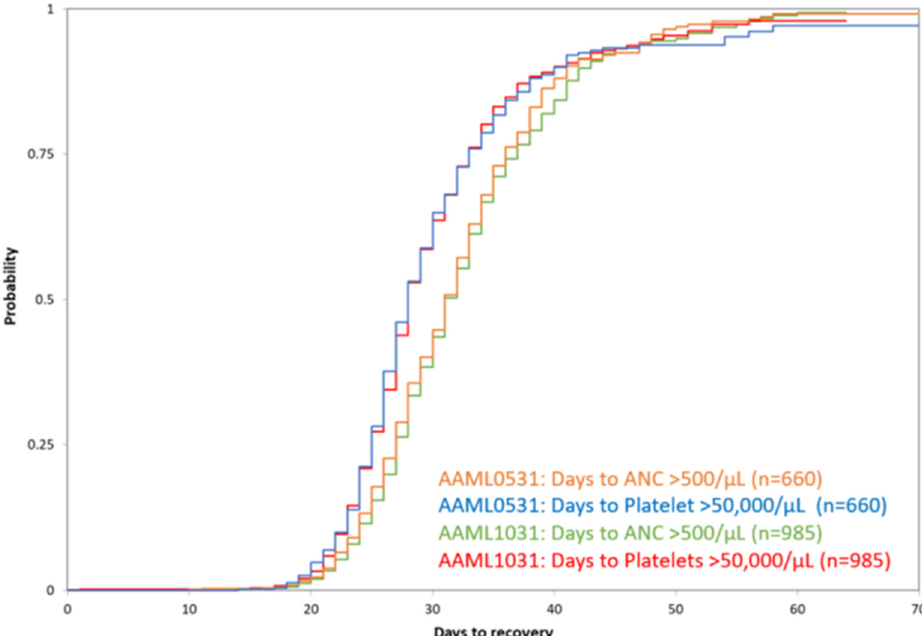
Figure 2. Cumulative incidence of count recovery. Count recovery in all patients with ≤ 5% bone marrow blasts by central Δ N flow cytometry at the end of Induction I who went on to receive Induction II therapy on AAML0531 and AAML1031.